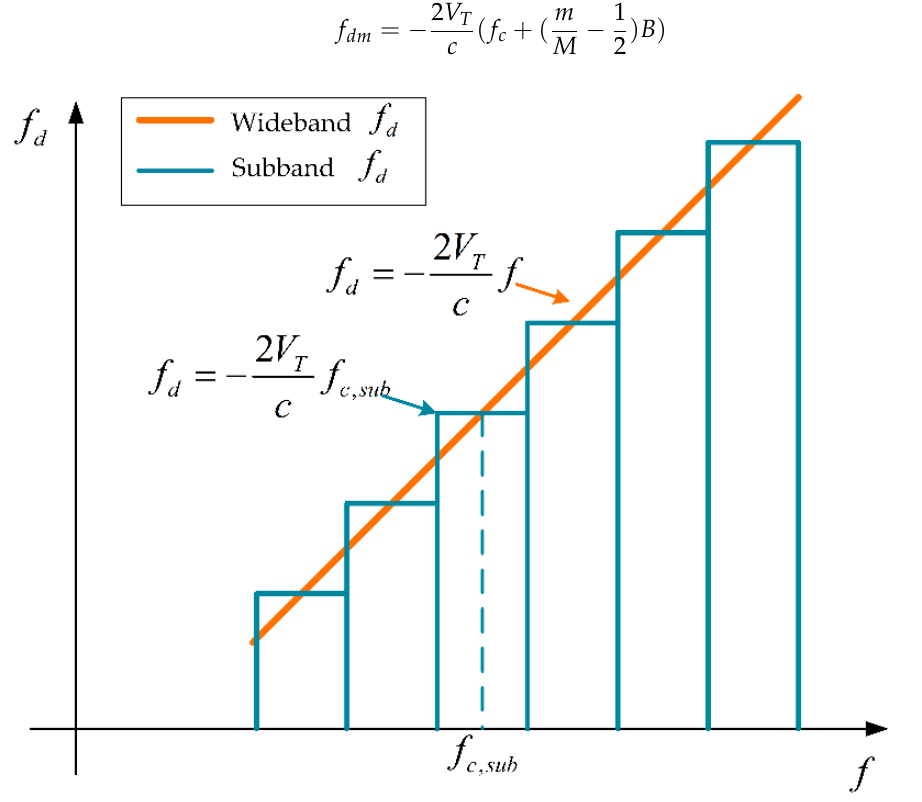
Figure 1. Doppler frequencies in different signal models.